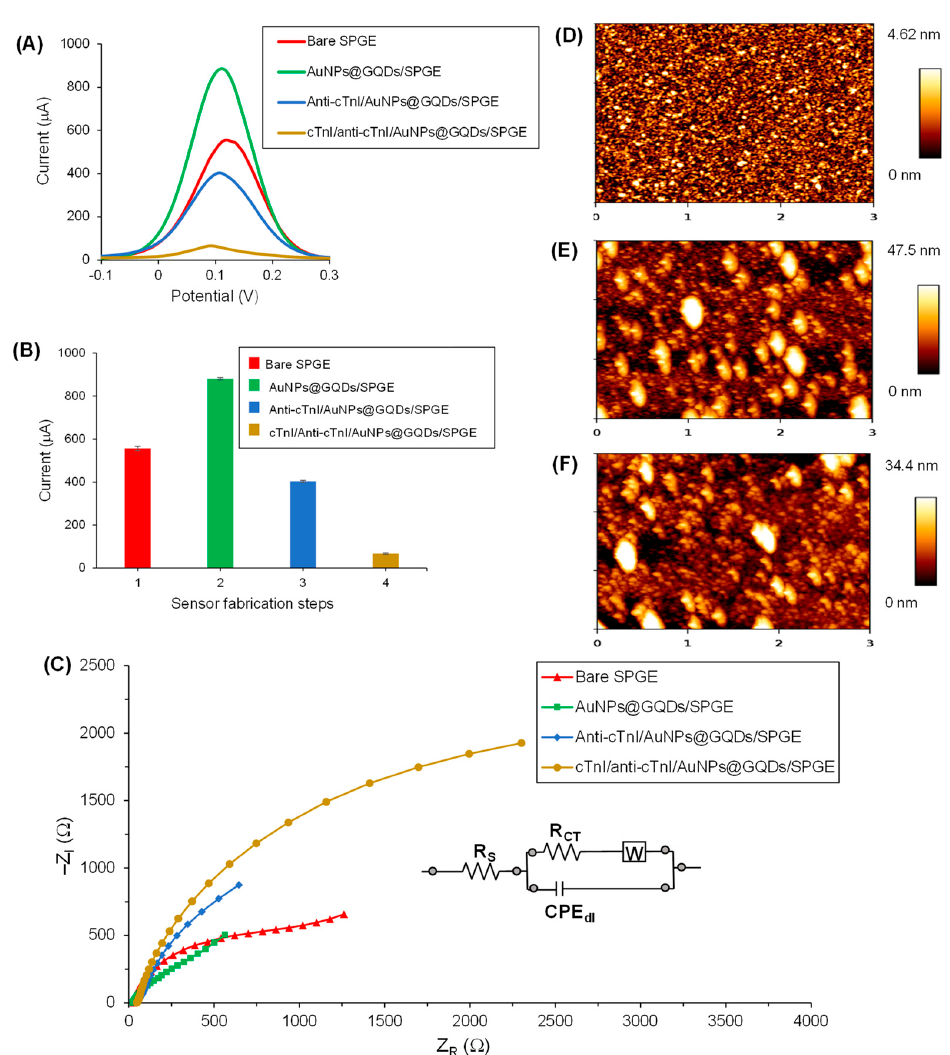
Figure 6. ( A ) Square-wave voltammograms recorded using redox marker containing 10 mM K 3 [Fe(CN) 6 ] and 0.1 M KCl for the bare SPGE (red curve), AuNPs@GQDs/SPGE (green curve) anti- cTnI/AuNPs@ GQDs/SPGE (blue curve) and cTnI/anti-cTnI/AuNPs@GQDs/SPGE (brown curve). ( B ) Comparison of the signal responses generated by each fabrication step. Step 4 involved 100 pg mL − 1 cTnI binding on the nanocomposite sensor. ( n = 3). ( C ) Nyquist plots recorded using redox marker containing 10 mM K 3 [Fe(CN) 6 ] and 0.1 M KCl for the bare SPGE (red curve), AuNPs@GQDs/SPGE (green curve), anti-cTnI/AuNPs@ GQDs/SPGE (blue curve) and cTnI/anti- cTnI/AuNPs@GQDs/SPGE (brown curve) using EIS. Concentration of cTnI: 100 pg mL − 1 . The inset shows the circuit model employed for the curve fittings. AFM 2D height images for ( D ) bare Si wafer, ( E ) AuNPs@GQDs/Si wafer and ( F ) anti-cTnI/AuNPs@ GQDs/Si wafer. The sensor fabrication steps were also characterized by AFM (Figure 6D–F and Fig- ure S6). The surface topographies, root-mean-square (RMS) roughness and 3D height im- ages